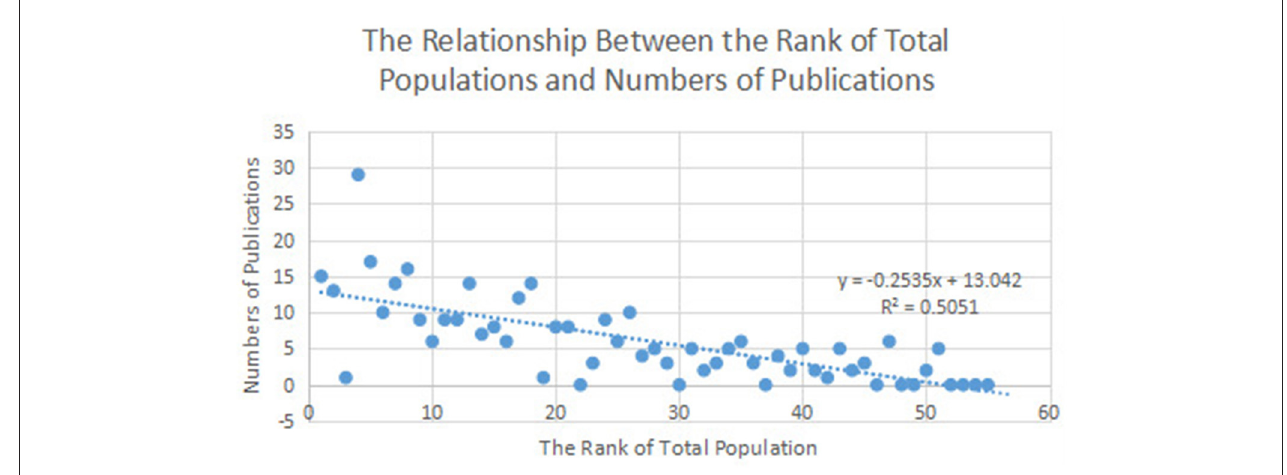
FIGURE 4 | The relationship between the rank of total populations and numbers of publications.